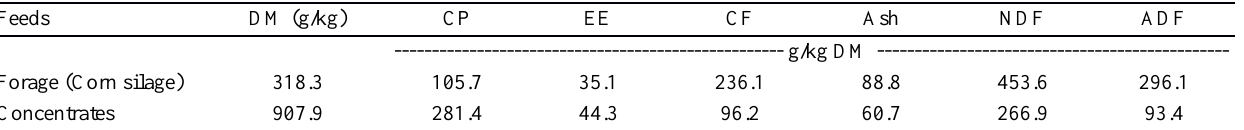
Table 1. Chemical compositions of forage and concentrate fed to animals Feeds DM (g/kg) CP EE CF Ash Forage (Corn silage)